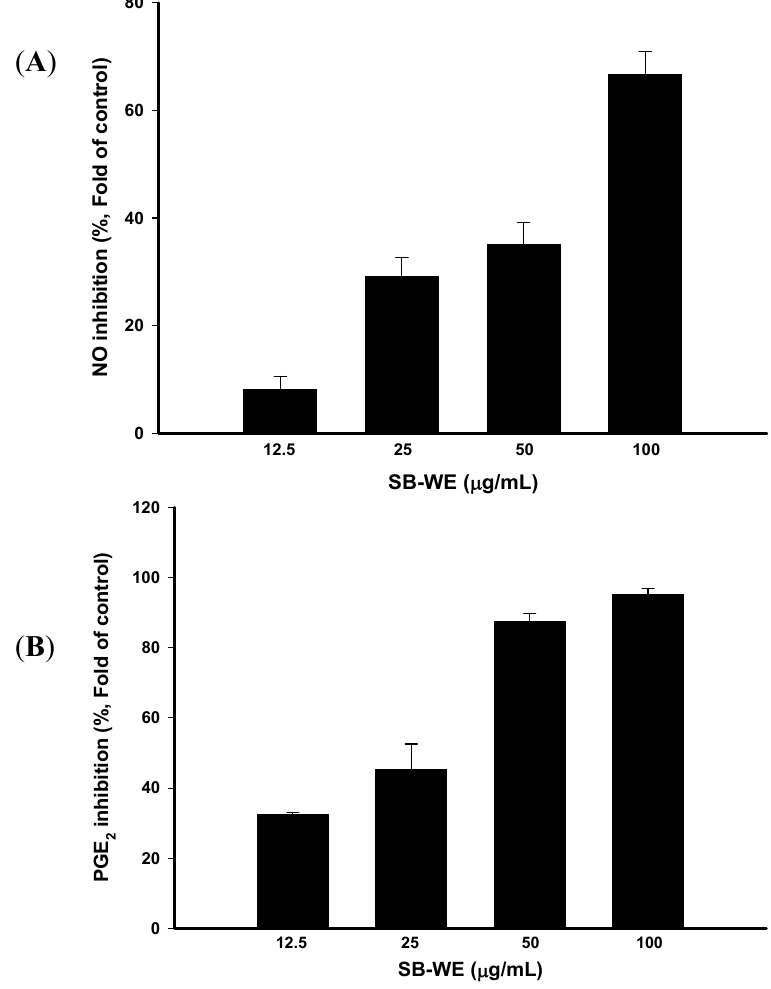
Figure 6. Anti-inflammatory effects of the boiling-water extract of S. baicalensis (SB-WE) on ( A ) NO and ( B ) PGE expressions in LPS-induced RAW 264.7 cells. n = 2